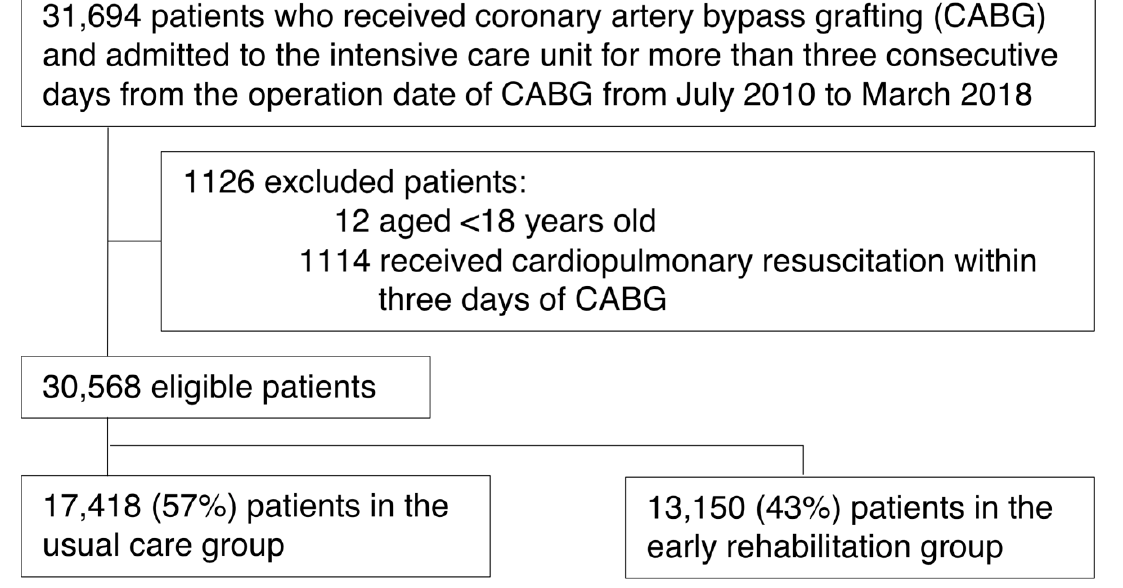
Figure 1. Patient inclusion/exclusion